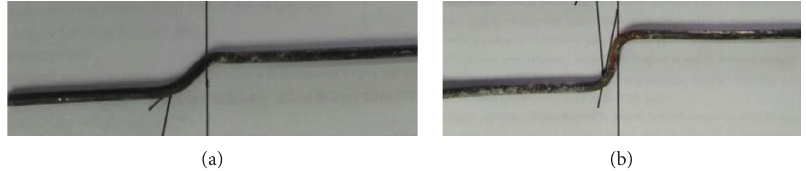
Figure 9: Shear deformation of the bolt with different inclinations. (a) 45 ° inclination. (b) 90 °